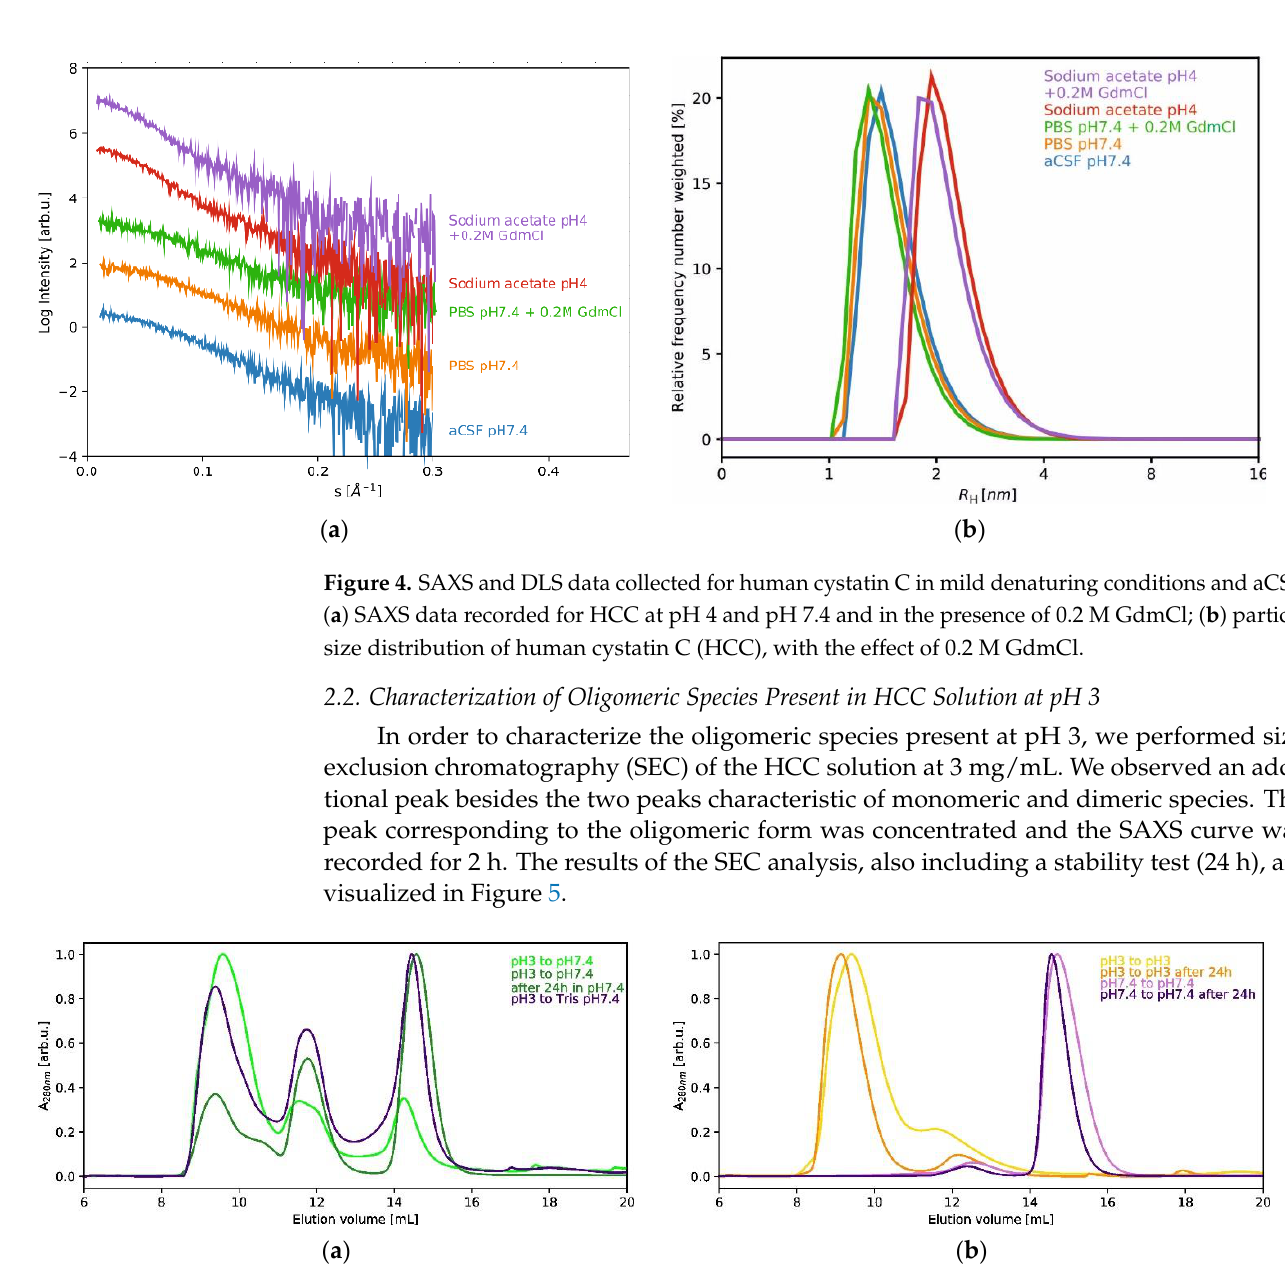
Figure 5. The results of the SEC analysis of the formation and stability of the tetrameric HCC form: ( a ) SEC elution profiles for HCC at pH 3 and transferred to pH 7.4 (PBS and Tris buffers); ( b ) SEC elution profiles for HCC at pH 3 transferred to pH 3 and pH 7.4 (PBS buffer). The chromatogram traces were normalized to value 1.